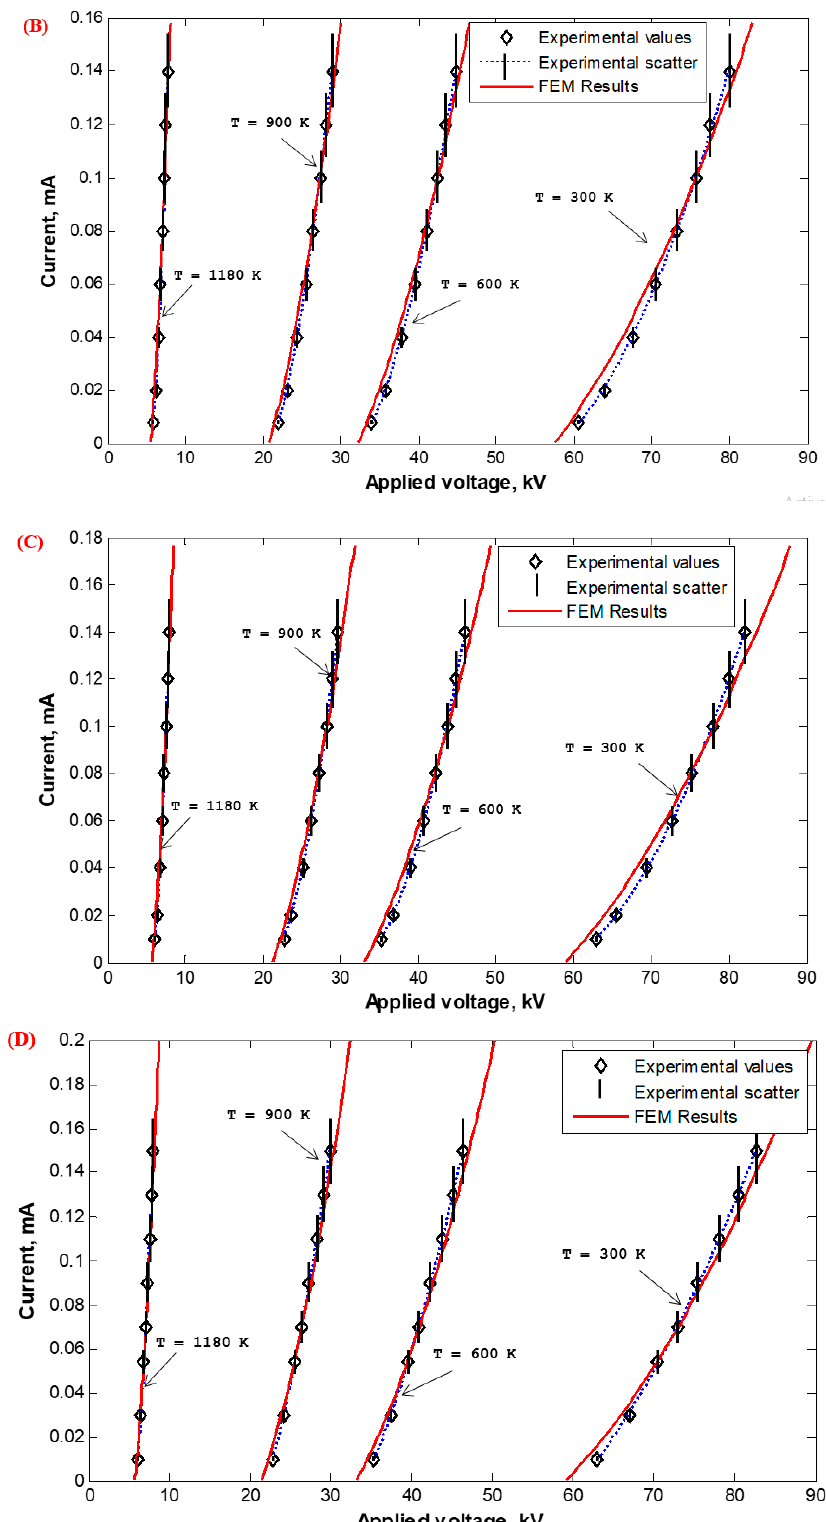
Figure 25. FEM molding and measured values experimentally for the I–V characteristics of WDESP ( r c = 1.975 mm) with high-temperature incoming gases for ( A ) single wire, ( B ) multi-discharge wire (three-wire), ( C ) multi-discharge wire (five-wire), and ( D ) multi-discharge wire (seven-wire).